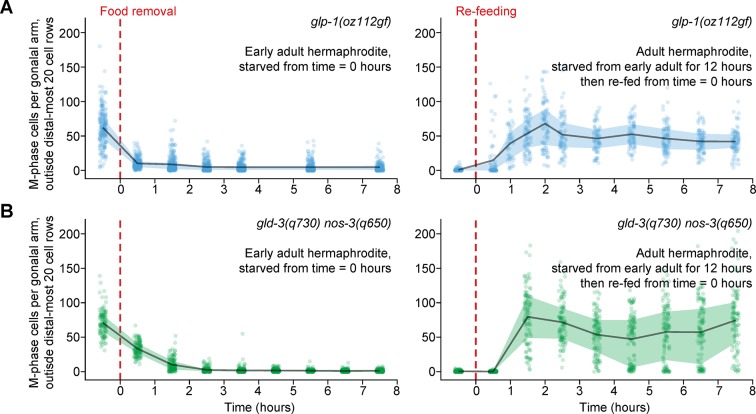
Re-feeding restores the rate of progression through S phase and G2, as well as the meiotic entry of transient progenitors.(A) Images of distal gonads dissected from emb-30(tn377ts) adult hermaphrodites and stained with DAPI to visualize DNA (magenta) and anti-GLD-1 (green). Animals were starved at 15°C, shifted to 25°C, and then either re-fed or maintained in starvation. Time = 0 hr indicates the time at which re-feeding was started or starvation continued. Top, starved adult hermaphrodite, Time = 0 hr. Middle, re-fed adult hermaphrodite, Time = 6 hr. Bottom, adult hermaphrodite maintained in starvation, Time = 6 hr. Dashed lines, ‘crescent’/‘non-crescent’ boundaries (defined by the second distal-most ‘crescent’ cell—see Materials and methods section). Arrowhead, an example of a metaphase-arrested cell having a high level of GLD-1. Asterisks, distal gonad ends. Images are maximum-intensity z-projections. (B) Time course showing the proportion of cells in M-phase (among the distal-most 50 germ cells) for emb-30(tn377ts) adult hermaphrodites treated as in A. n = 31–66 gonadal arms per time point. (C) Number of cells distal to the ‘crescent’/‘non-crescent’ boundary for the same gonads used in B. (D) Cell-cycle behavior, among cells distal to the ‘crescent’/‘non-crescent’ boundary, for the same gonads used in B. Cells from individual gonadal arms are plotted along lines, with color indicating cell-cycle phase (interphase or M-phase) and location determined by each cell’s position along the distal-to-proximal axis of distal gonad. For each time point, this axis is scaled relative to the mean number of cells distal to the ‘crescent’/‘non-crescent’ boundary. (E) Summary of the effects of re-feeding and continued starvation on germ cells in emb-30(tn377ts) hermaphrodites in the distal versus proximal progenitor zone. Source data are available in Figure 4—source data 1.DOI:
http://dx.doi.org/10.7554/eLife.10832.01410.7554/eLife.10832.015Figure 4—source data 1.Temperature-shift experiments of emb-30(tn377ts) hermaphrodites.This comma-separated value file contains counts of interphase and M-phase progenitor-zone cells for emb-30(tn377ts) hermaphrodites re-fed at the restrictive temperature or maintained in continued starvation (Figure 4). Each row of the file represents a single cell. Descriptors include treatment group (re-fed, starved), cell-cycle phase (interphase, M-phase), ranked proximity to the distal tip cell (numeric), time, and a gonad identifier.